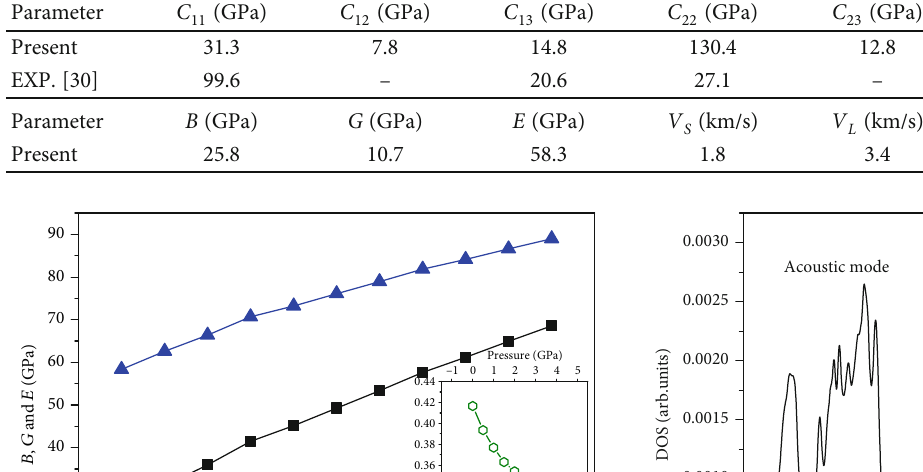
S at 0 pressure. 2 3